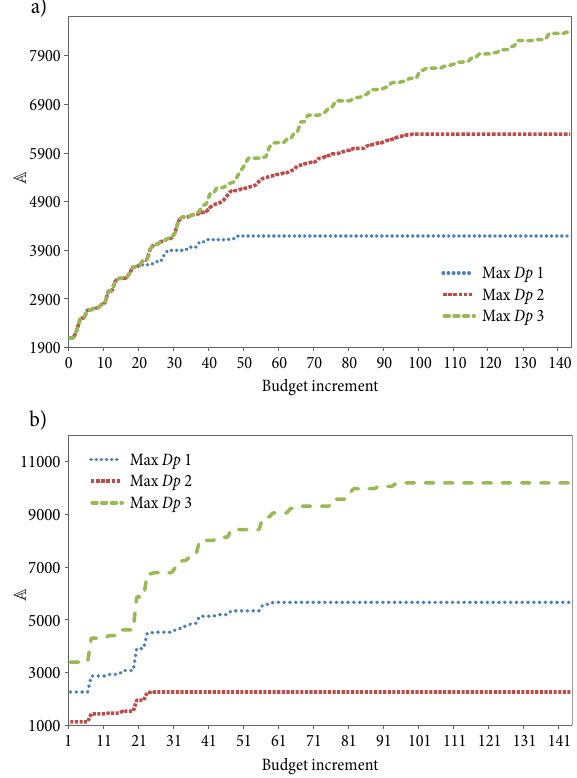
Fig. 7. Absolute capacity by budget increment: a – equal PF ;